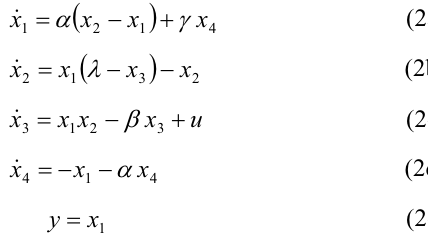
Fig. 1 Phase portrait of